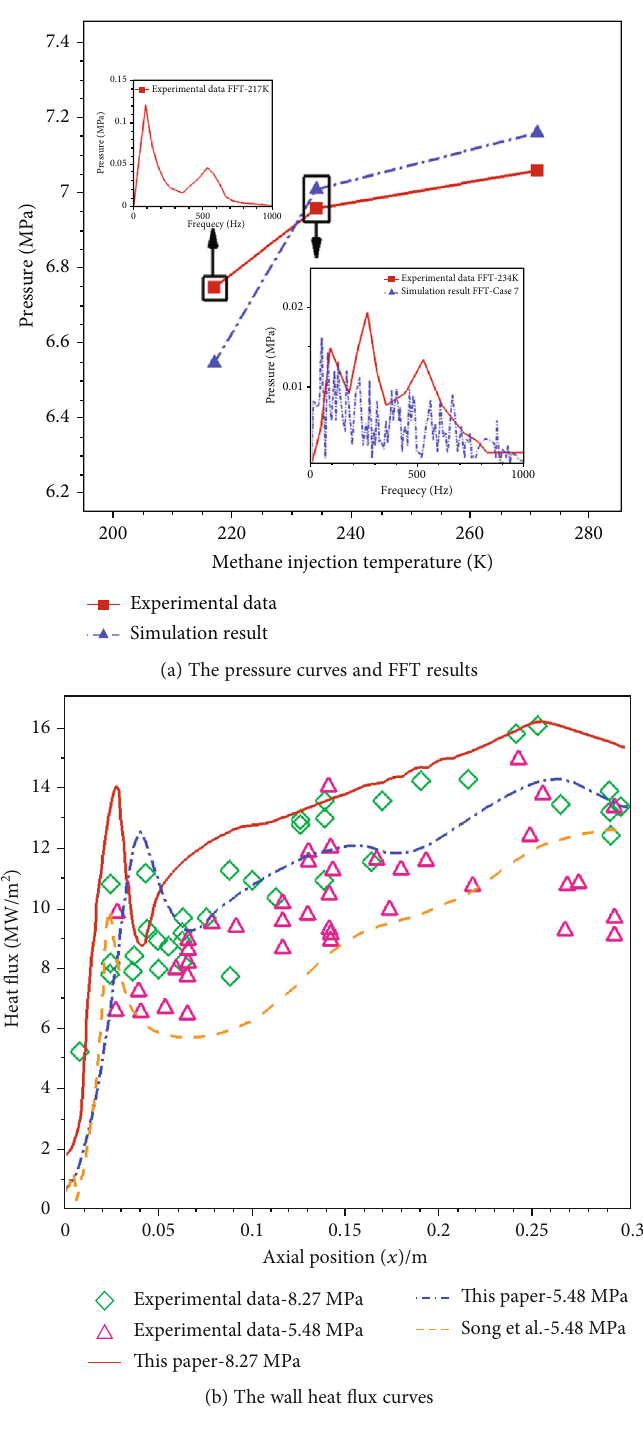
Figure 3: The comparison between experimental data and simulation result. Table 3: Various grid